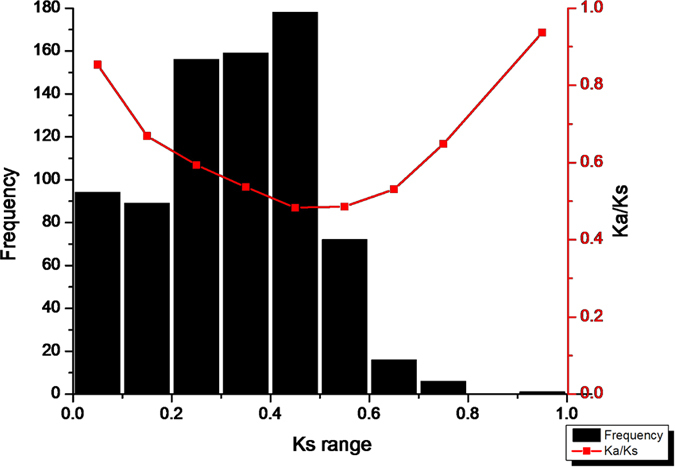
The frequency distribution of relative Ks nodes (bar chart) and the relationship between Ks and Ka/Ks (line chart).The X-axis denotes average Ks per unit of 0.1 and Y-axis denotes frequency and average Ka/Ks ratios, respectively.